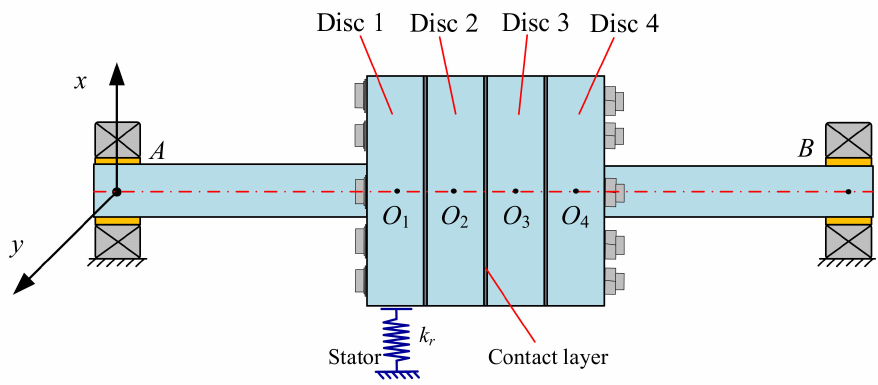
Figure 2. Schematic diagram of a multi-disc bolted joint rotor-bearing system with rubbing